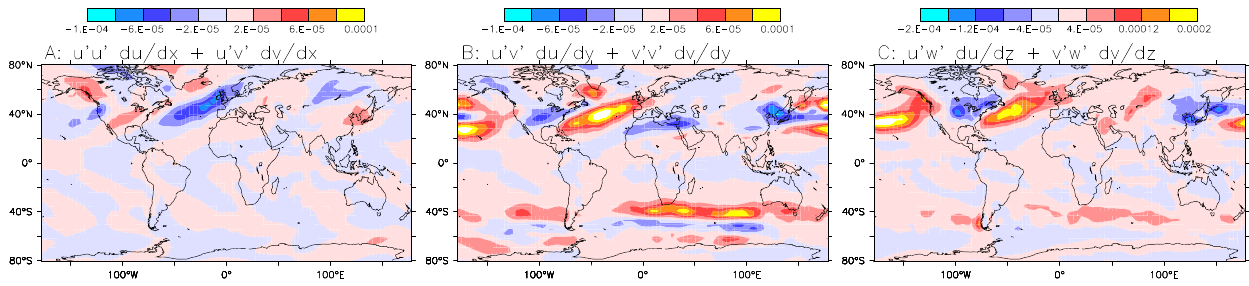
Fig. 1. Band-pass filtered ERA-40 data of terms capturing exchange of kinetic energy between eddies and the large scale flow (in m 2 s − 3 ) arising from (a) zonal, (b) meridional and (c) vertical shear of the large scale wind field at 500mb for January. Note the different scale in (c)